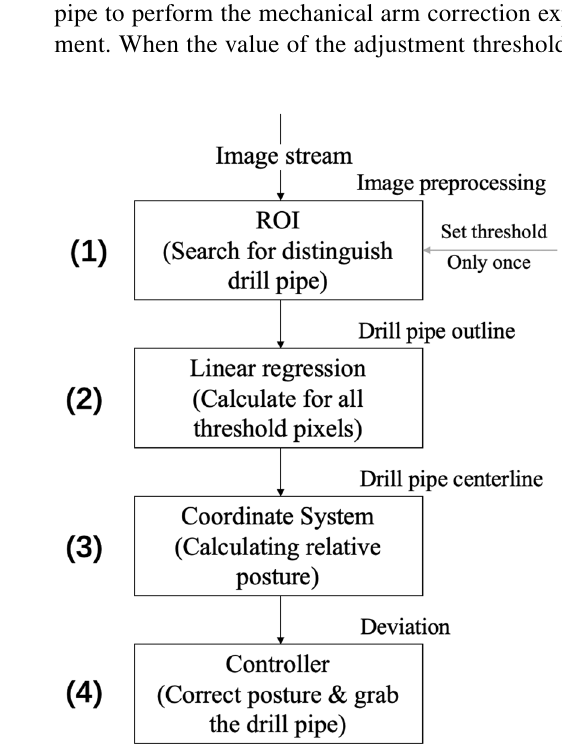
Fig. 7 Flowchart of visual servo control